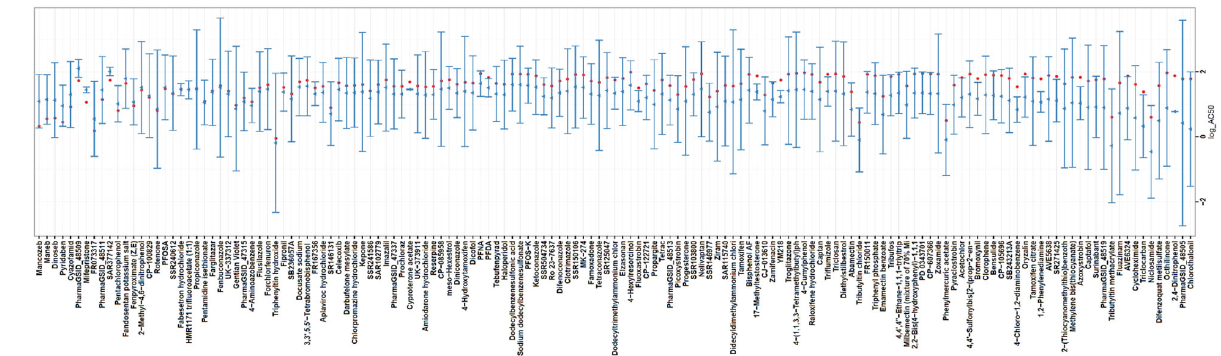
Fig. 3 Comparison of cytotoxic activity. Using cells with xenobiotic metabolism capacity may permit identi fi cation of compound toxicity resulting from a chemical metabolite. A The log AC50 values (dot) for the compounds positive in the HepaRG TM cytotoxicity assay, as determined by measure of lactate dehydrogenase (LDH) release, were compared with a range of cytotoxicity measurements made in other cell lines and primary cells (whiskers). Cytotoxicity measurements for the other cell types used a range of techniques, primarily ATP level determinations, but did not include LDH release While assay-speci fi c sensitivities may in fl uence results, overall, few compounds showed enhanced cytotoxicity in the HepaRG TM